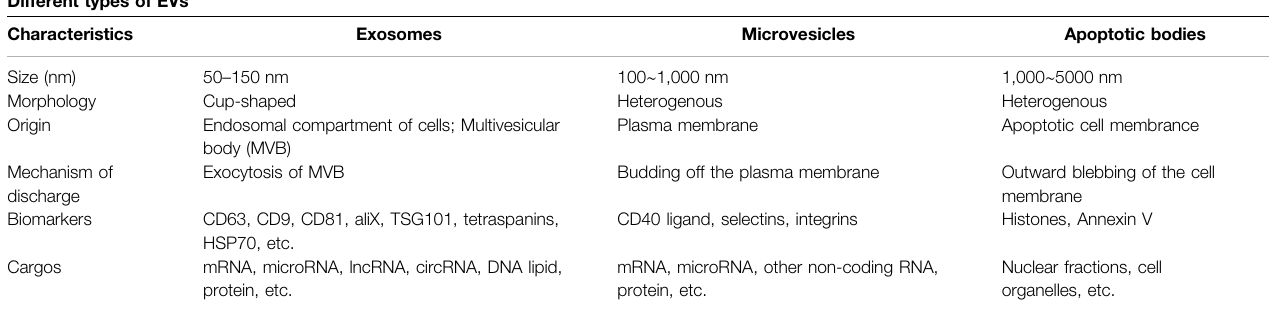
TABLE 1 | Summary of details for exosomes, microvesicles, and apoptotic bodies. Different types of EVs